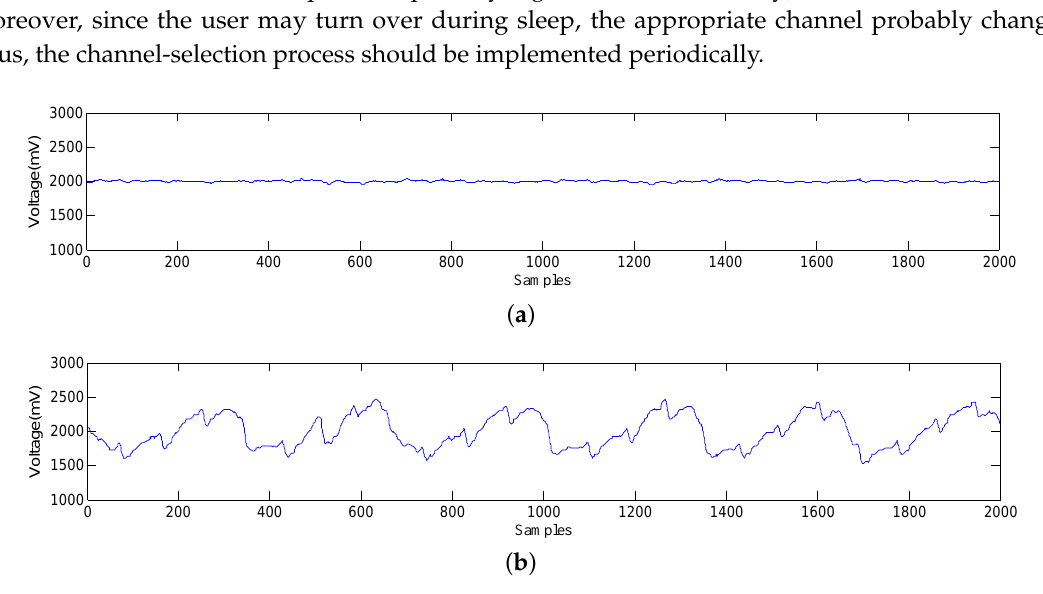
Figure 4. Illustration of data collected by different sensors. ( a ) Data from a sensor with weak signals; ( b ) Data from a sensor with strong